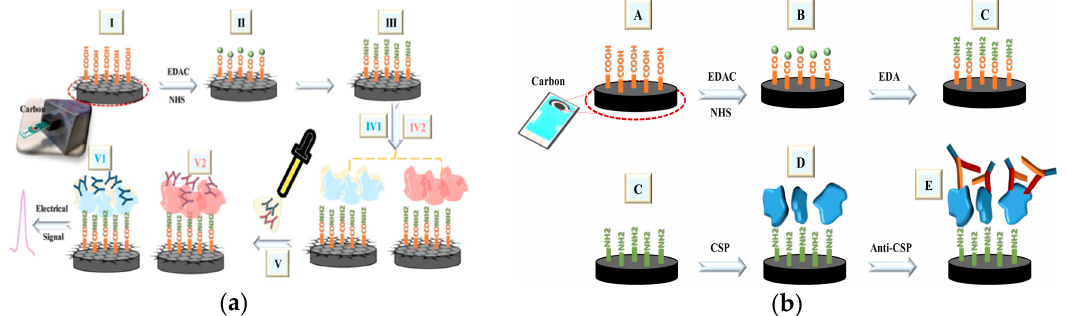
Figure 2. ( a ) Schematic of the fabrication of the Zika virus (ZIKV) antibody-detecting biosensor by activation of carboxylic acid ends (II), and incubation with NS1 and EDIII protein (IV1 and IV2, respectively). (Adapted from Ref. [30]. Copyright © 2018 Elsevier B.V.) ( b ) Schematic of the fabrication of the circumsporozoite (CSP) antibody detecting biosensor. Carboxylic acid ends are activated (B), aminated by the addition of ethylenediamine (C), incubated with CSP protein 210-247 (D), and bound to Anti-CSP 210 or 247 (E). (Adapted from Ref. [31]. Copyright © 2017 Elsevier B.V.)